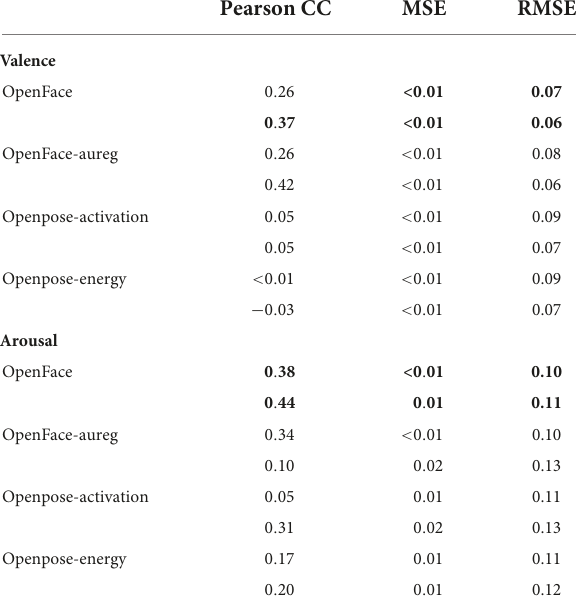
TABLE 2 Emotion recognition model (ERM) comparison for the emotion dimensions arousal and valence based on different feature streams.